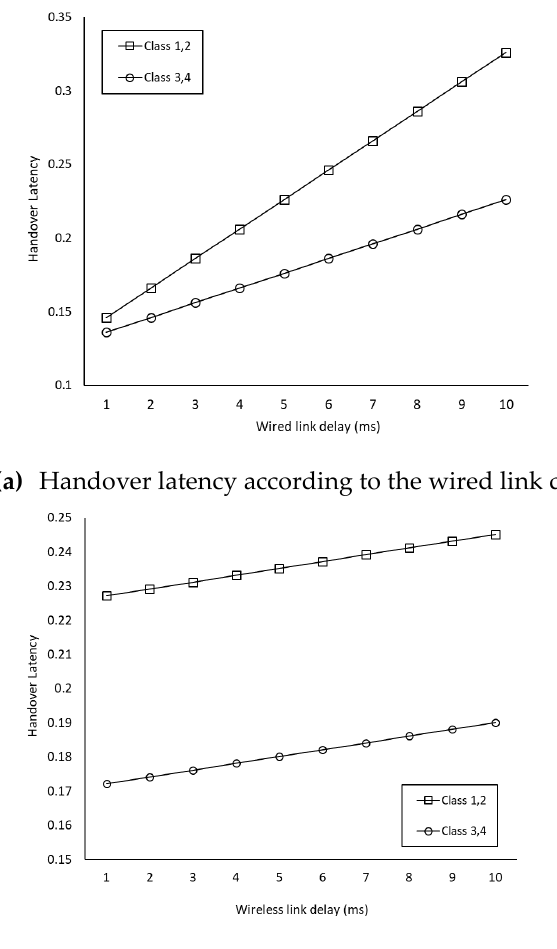
Figure 4. Handover latency according to the wired ( a ) and wireless link delay ( b ).